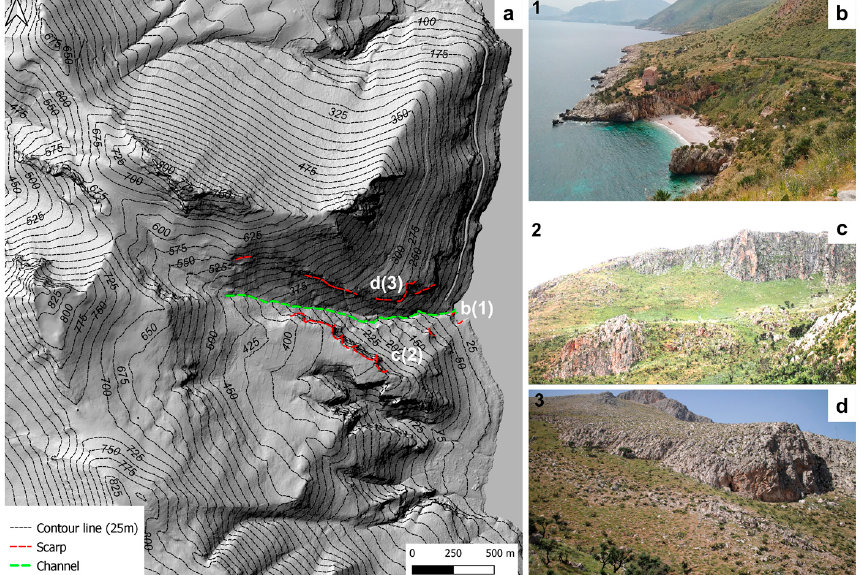
Figure 5. ( a ) Main sources of the sedimentary contribution (scarps and channel) to the pocket beach and some explanatory pictures related to the scarps as source areas of the rockfall; ( b ) headlands bounding the pocket beach that prevent/limit long-shore sediment transport and, at the same time, contribute to the evolution with materials derived from rockfall; ( c ) scarp as sedimentary contribution area on the right side of the slope unit; and ( d ) scarps as sedimentary contribution areas on the left side of the slope unit.